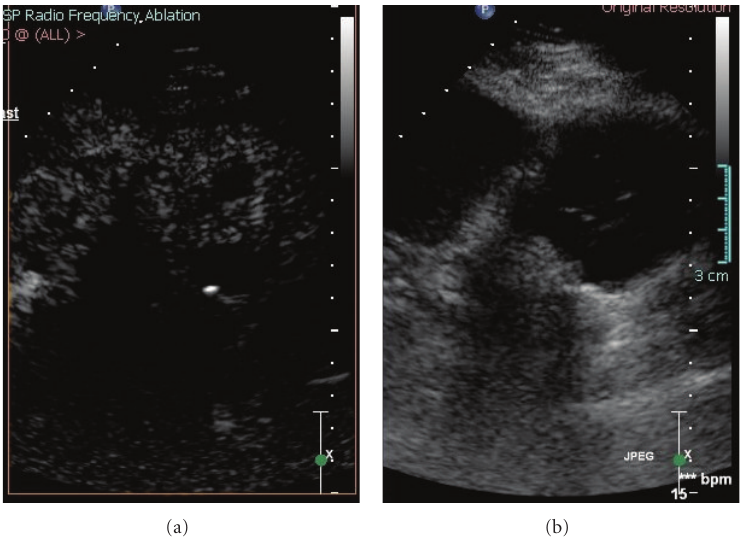
Figure 2: Ultrasound contrast image and grey scale ultrasound before ablation show the perfusion of solid mass (a) and hypoechoic mixed cystic and solid mass (b).